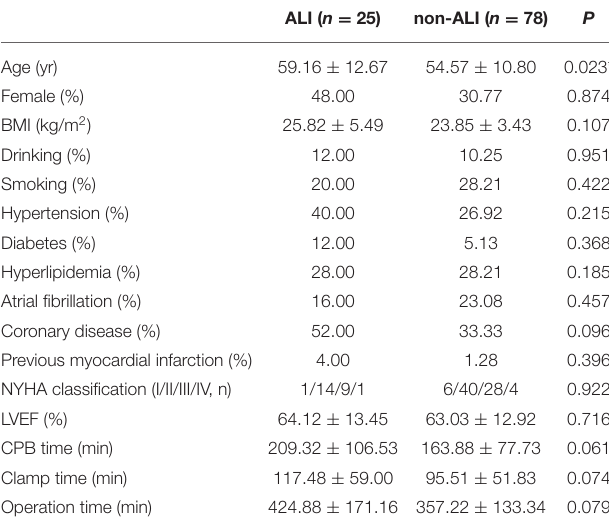
TABLE 1 | Perioperative clinical parameters between the ALI and non-ALI groups.